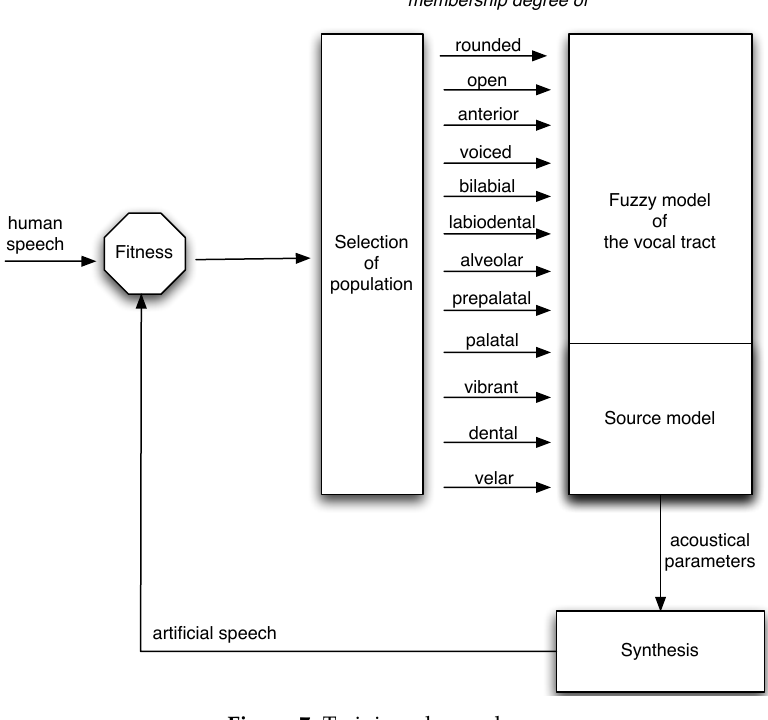
Figure 7. Training phase